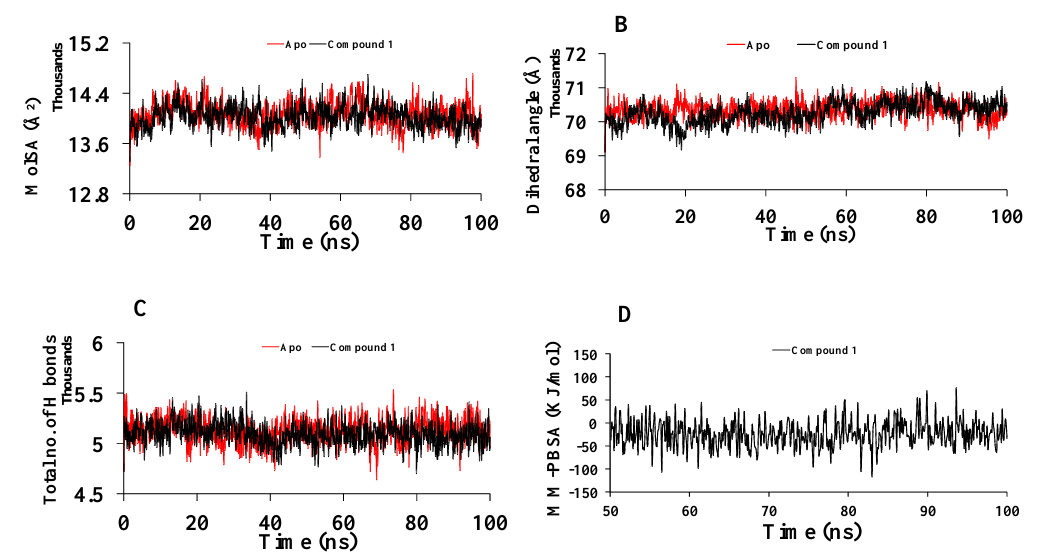
Figure 7. ( A ) Molecular surface area value of apo-Mpro and compound 1-Mpro along the 100 ns MD simulations. The structural changes of Mpro by means of ( B ) dihedral angle, ( C ) total number of H bonds formed during the simulation, and ( D ) binding free energy analysis of Compound 1 - Mpro.